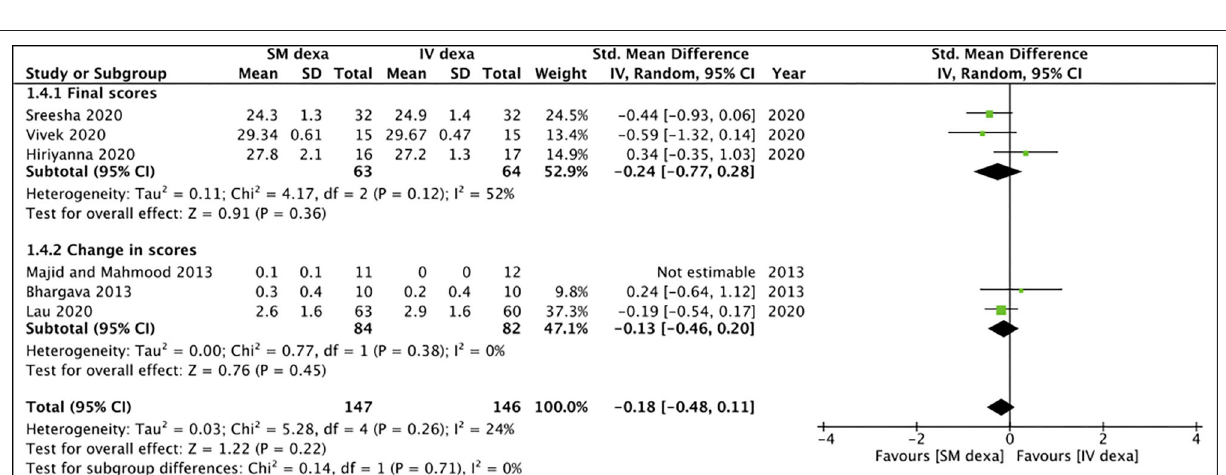
FIGURE 5 | Meta-analysis of late swelling between SM and IV dexamethasone (dexa) for third molar surgeries. Sub-group analysis performed based on final scores or change scores.